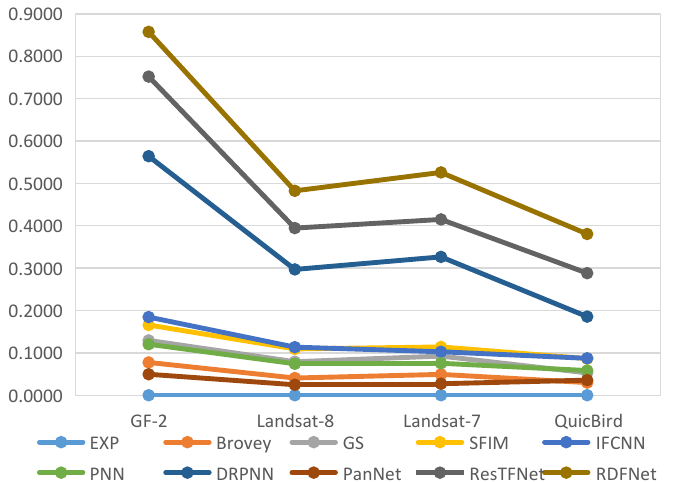
Figure 27. All the CNN-based methods are implemented on a GPU, other methods are implemented on a CPU. Test time (s) of testing datasets with reduced